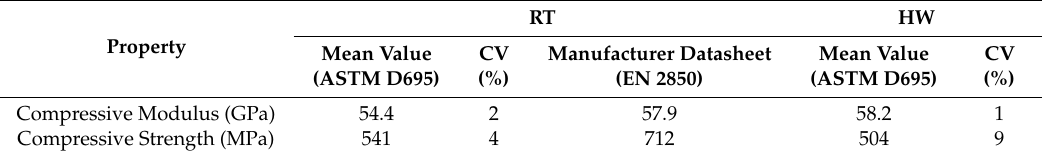
Table 6. E ff ect of hot-wet storage aging on compressive properties of [90] Table 6. Effect of hot-wet storage aging on compressive properties of [90] laminates.